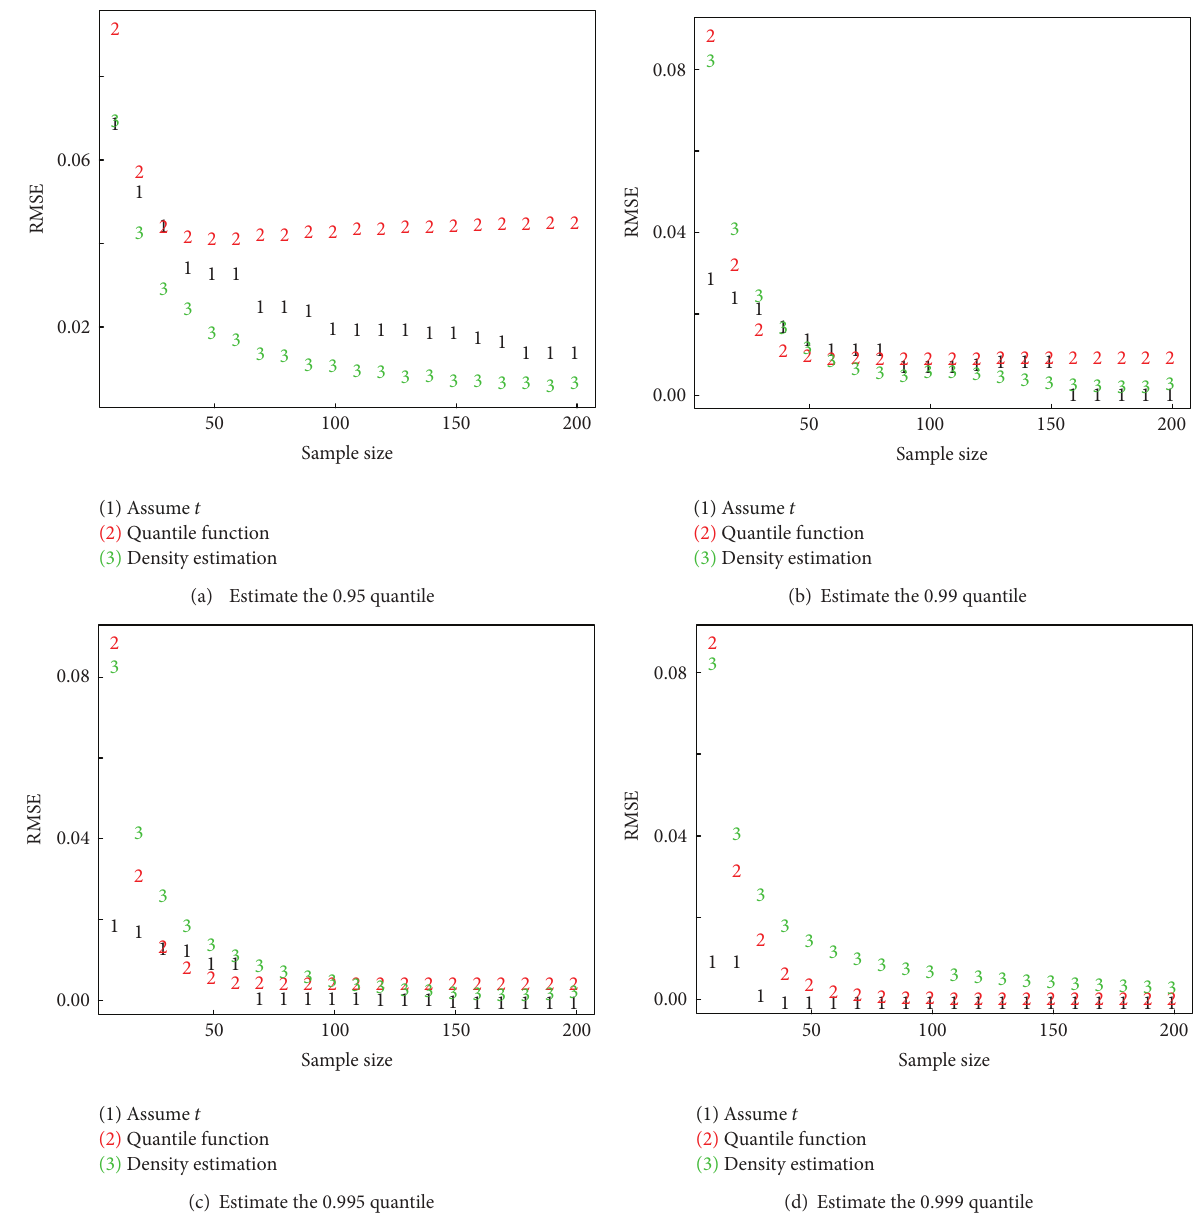
Figure 11: RMSE versus sample size assuming a normal distribution for three estimation options labeled 1–3. The true RMSEs were estimated by simulation of 10 4 observations in R , and results are repeatable to within ±0.001 . Option 1 correctly assumes a t (2) distribution. Option 2 uses the quantile function in R . Option 3 is density estimation as discussed in Section 3.6.1. This is the same as Figure 10, but for a 𝑡(2) distribution rather than a normal